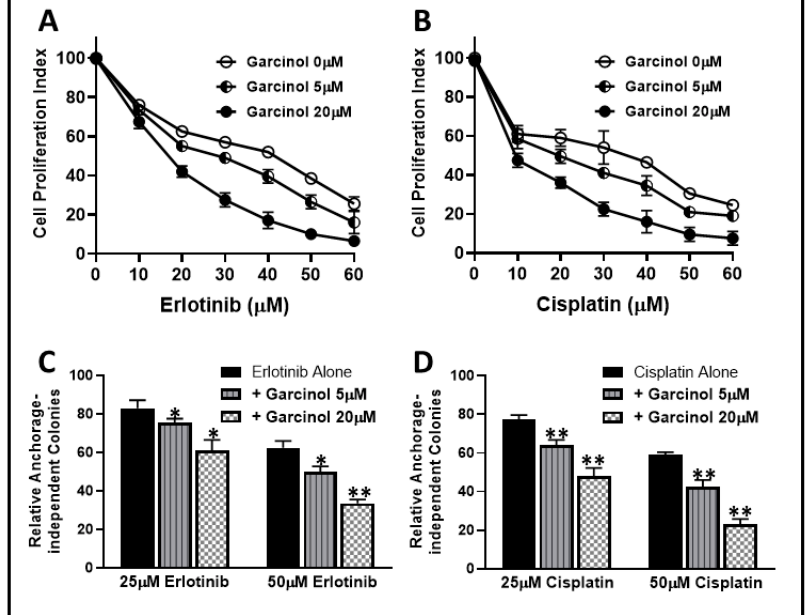
Figure 2. Garcinol sensitizes transforming growth factor beta 1 (TGF- β 1)-induced epithelial-to-mesenchymal transition (EMT) cells, A549M to therapy. A549M cells were treated with increasing doses of erlotinib ( A ) and cisplatin ( B ) in the absence (garcinol 0 µ M) as well as presence of increasing doses of garcinol (5 and 20 µ M) for 72 h and then subjected to 3-(4,5-dimethylthiazol-2-yl)-2,5-diphenyltetrazolium bromide (MTT) assay. ( C , D ) The effect of such treatment on anchorage-independent colony formation was also observed. The number of colonies are represented as %, relative to the control conditions with no erlotinib/cisplatin or garcinol. * p < 0.05 and ** p < 0.01, compared to erlotinib alone. Table 1. Garcinol lowers the IC 50 of erlotinib/cisplatin in A549M cells.